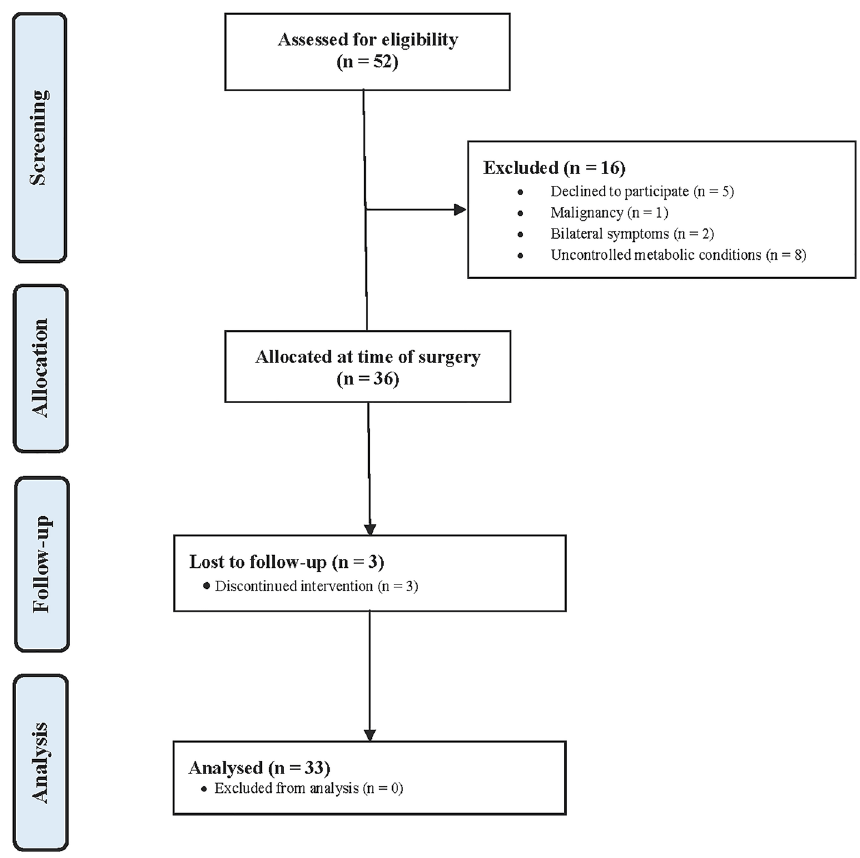
Figure 3. Flow-chart of the enrolment process.